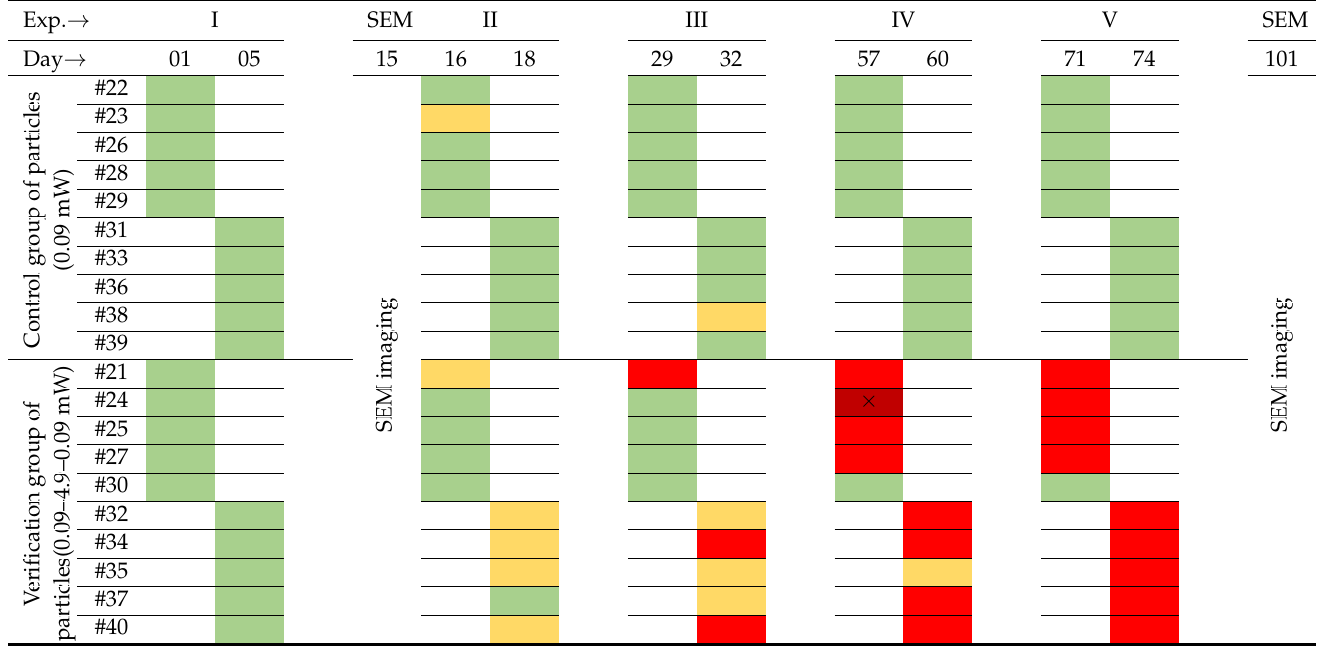
Table 1. Comparison of degradation processes for control and verification groups (green: non- degraded particles, red: degraded between measurements, dark red: degraded during Raman measurement, and yellow: a particle with ambiguous Raman spectra). Second raw helps